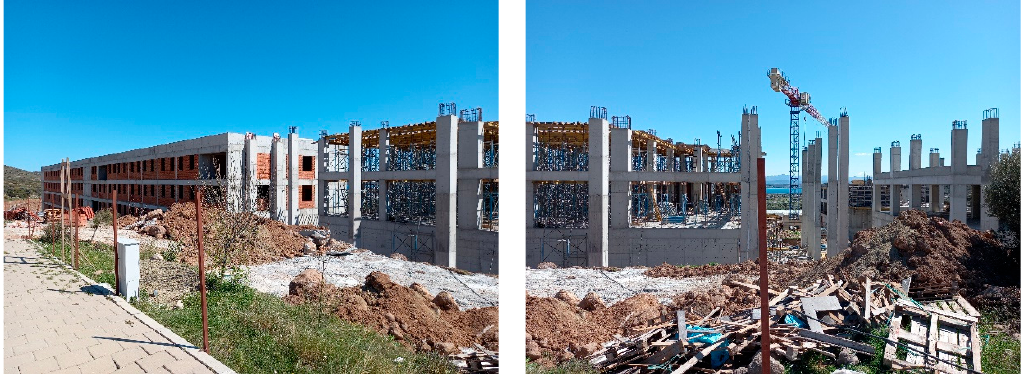
Figure 6. The construction site of the new dormitory.